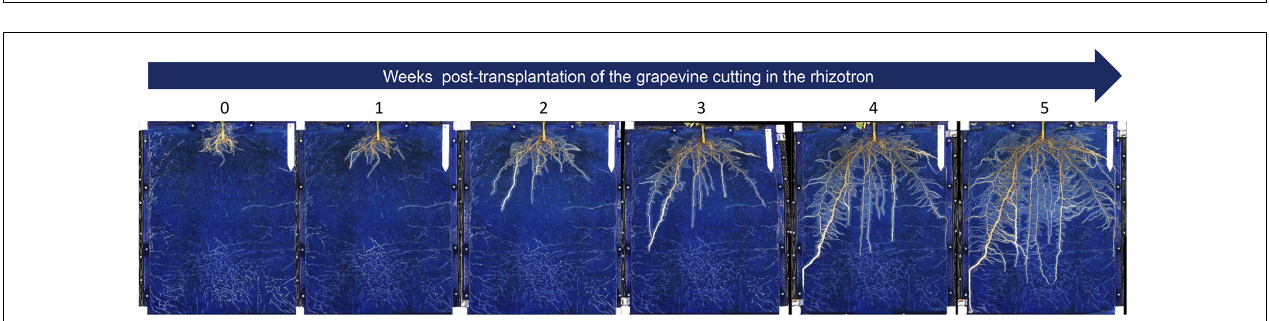
FIGURE 3 | Grapevine herbaceous cutting growth and development in a hydroponic tube over time (i.e., weeks after diving an unrooted cutting into water). Cap-free Falcon R (cid:13) tubes filled with water were closed on top by a piece of holed Parafilm R (cid:13) , through which an unrooted cutting was placed. Tubes were held vertically on an empty seed starting tray. The four pictures show the development of the root system for 4 weeks (1 image per week).